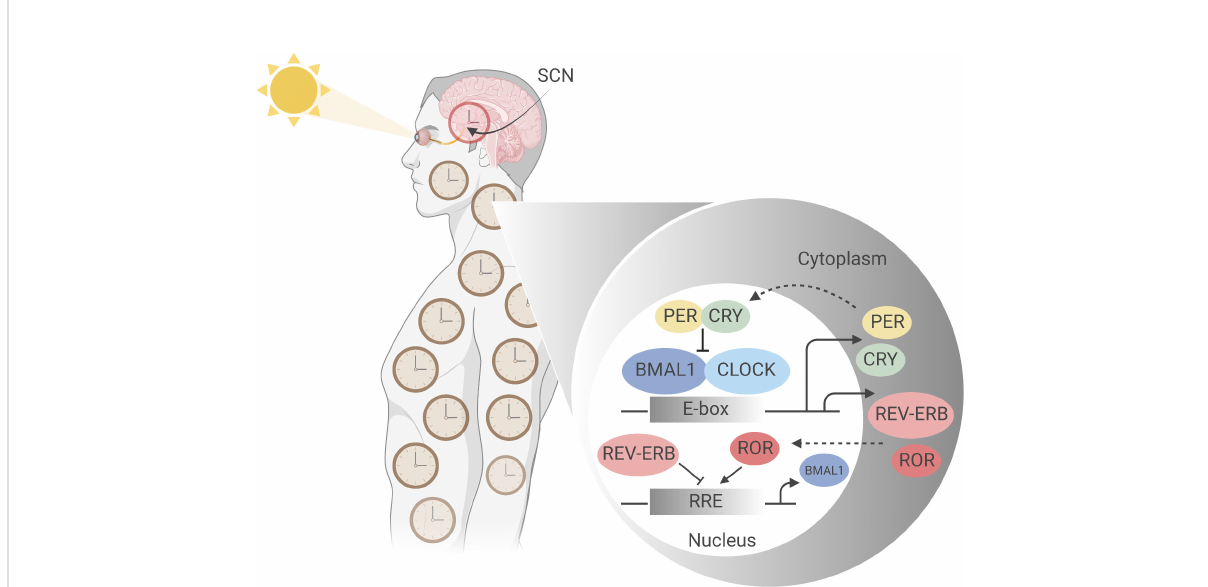
FIGURE 1 Molecular mechanism of the mammalian circadian clock. The mammalian circadian clockwork comprises a set of conserved, self-sustaining transcriptional- translational feedback loops that begin at ‘ dawn ’ with transcription factors CLOCK and BMAL1, the positive regulators of the central loop. CLOCK and BMAL1 heterodimerize and bind E-box regulatory elements to drive the expression of target genes including Period (Per) and Cryptochrome (Cry) clock genes (5). Accumulating in the cytoplasm over the course of the circadian day, negative regulators PER and CRY, having complexed to form PER-PER homo- or PER-CRY heterodimers, translocate into the nucleus where they inhibit CLOCK : BMAL1 activity at E-box sites, thereby suppressing their own synthesis (6, 7). Subsequent PER and CRY degradation at ‘ night ’ allows resetting of the clock, and CLOCK : BMAL1 activity to resume. This generates stable oscillations in target gene expression with a period of approximately 24 hours (8). PER and CRY stability is thus integral to circadian periodicity: mutations affecting their phosphorylation state, for example, dramatically alter period length, as fi rst demonstrated by Menaker ’ s tau mutant hamster, which is a gain of function mutation in CK1 e (9). A second feedback loop comprises CLOCK and BMAL1 driving expression of nuclear receptors ROR a (NR1F1), REV-ERB a (NR1D1) and its paralogue REV-ERB b (NR1D2), which act via ROR-response elements (RORE) in the proximal Bmal1 promotor to modulate Bmal1 expression; ROR a as a transactivator and the REV-ERBs as transrepressors (5). Figure created with